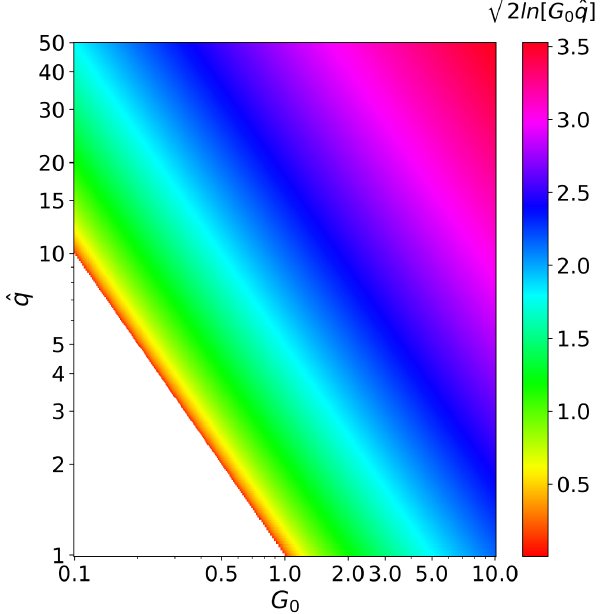
ffiffiffiffiffiffiffiffiffiffiffiffiffiffiffiffiffiffi p ˆ q (cid:3) 2 ln ½ G for static 0